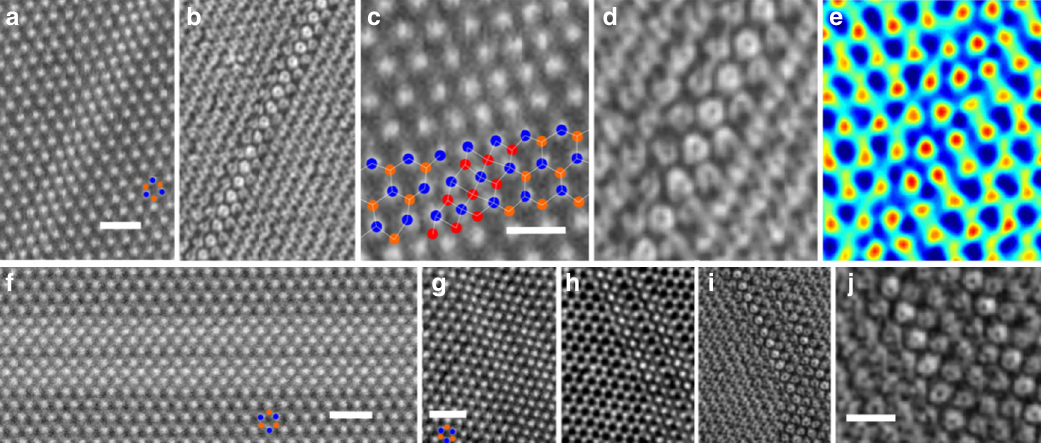
Fig. 5 4D STEM of larger width line vacancy channels in WS 2 . a LAADF image of a 3S line defect in WS 2 reconstructed from the 4D STEM data. Scale bar indicates 1 nm and is applicable for panel ( b ). Blue spots indicate W and orange 2S positions. b | E ┴ | image reconstructed from 4D STEM data. c Magni fi ed view of the ADF-STEM image reconstructed from 4D STEM data of a 3S line vacancy, S vacancy sites indicated by red dots. Blue dots mark W atom sites and orange dots 2S sites. Scale bar indicates 0.5 nm and is applicable to panels ( c ) − ( e ). d | E ┴ | image reconstructed from 4D STEM data. e Total charge map reconstructed from 4D STEM data. Color scaling is the same as that used in Fig. 2m. f High-resolution ADF-STEM image recorded using an annular detector of a complex wider line defect in WS 2 . Scale bar indicates 1 nm. Blue spots indicate W atom sites and orange indicates 2S sites. g LAADF image of a complex line defect in WS 2 reconstructed from the 4D STEM data. Scale bar indicates 1 nm and is applicable to panels ( g ) − ( i ). Blue spots indicate W atom sites and orange indicates 2S positions. h Ptychographic phase of a complex line defect area in WS 2 reconstructed using the ePIE algorithm applied to 4D STEM data. i | E ┴ | map around a complex line defect in WS 2 reconstructed from 4D STEM data. j Magni fi ed view of the | E ┴ | map in ( i ). Scale bar indicates 0.5